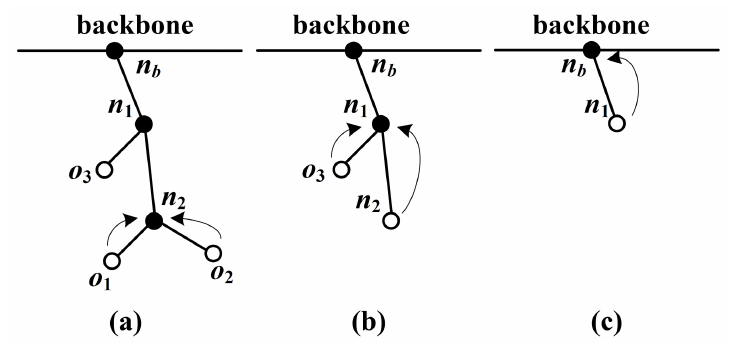
Figure 2. An example of the impedance carry back method using three steps in (a), (b) and (c), respectively